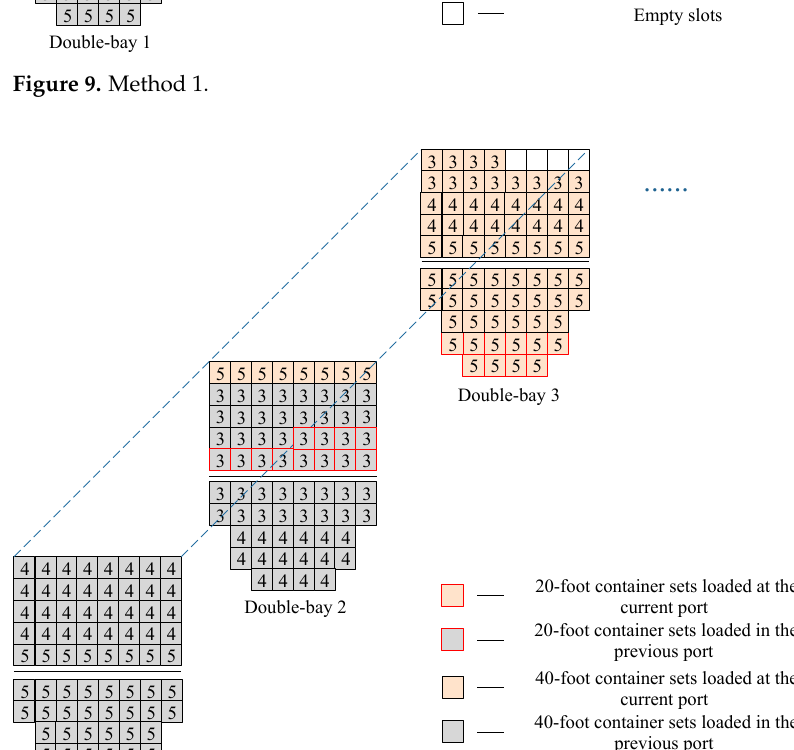
Figure 9. Method 1.